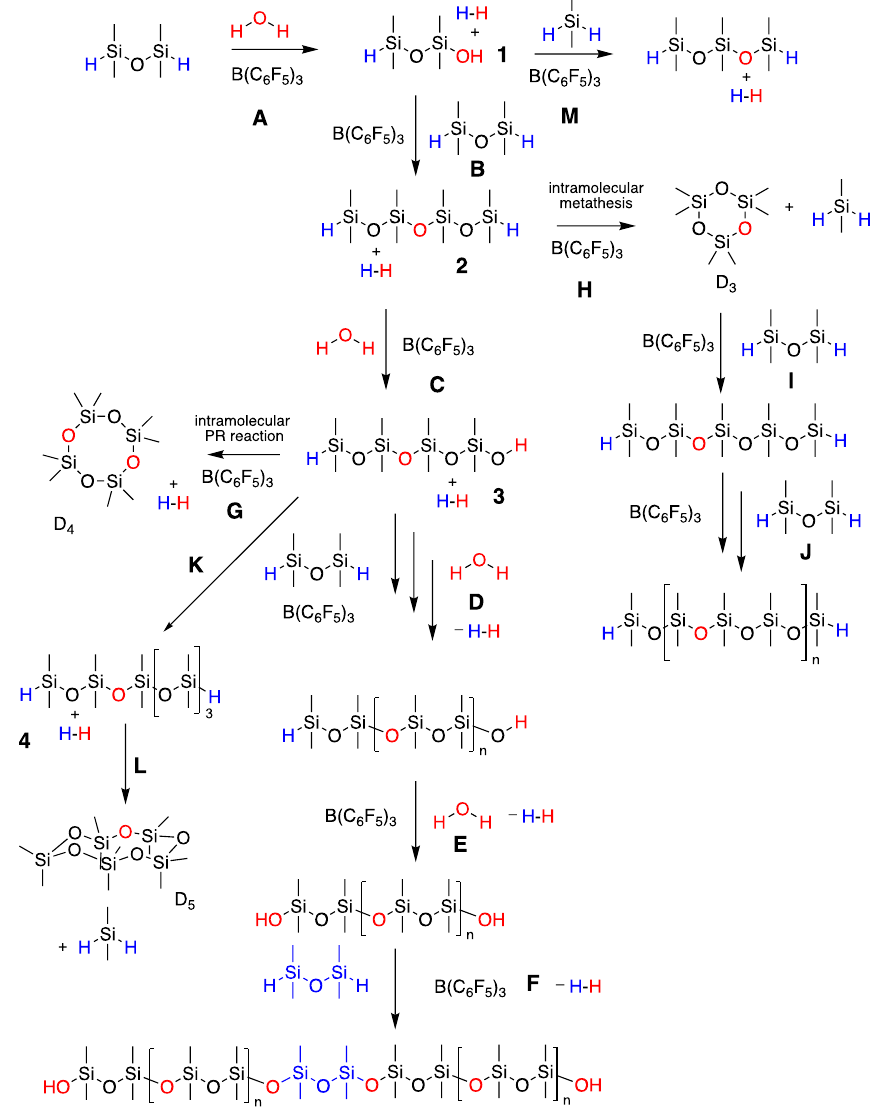
Figure 3. Proposed reactions for cyclooligosiloxane and polymer formation from M H M H . Hydrolysis of SiH compounds to give hydroxy-capped ( A ) dimer; ( C ) tetramer; ( D , E ) polymers. Chain extension to give HSi-terminated ( B ) tetramer; ( F ) polymer; ( K ) hexamer. Chojnowski metathesis to give ( H ) D 3 ; ( K ) D 5 ; ( L ) Me 2 SiH 2 ; ( G ) Cyclization to give D4. ( I , J ). Metathesis polymerization to higher polymers. ( M ) Chain homologation between silanols and Me 2 SiH 2 .